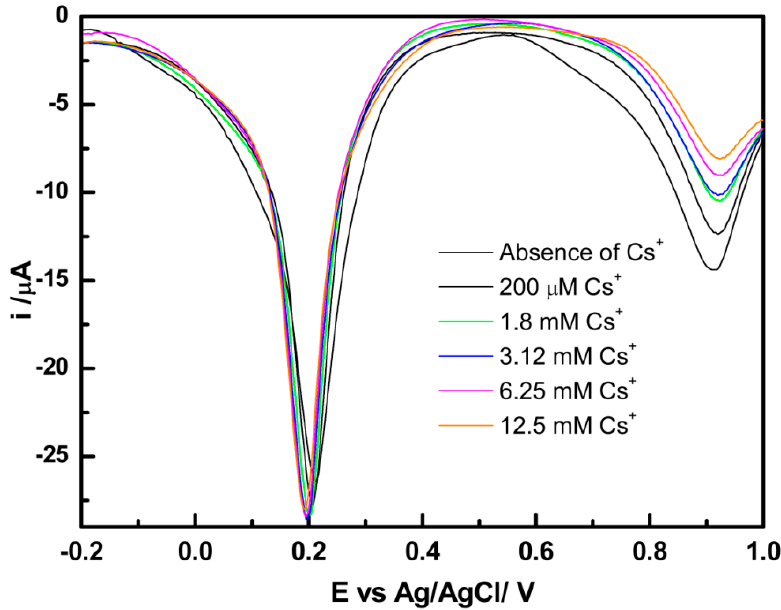
Figure 8. Differential pulse voltammetry of the PB nanoparticle-modified screen-printed electrode in the presence of varying concentrations of Cs ions.